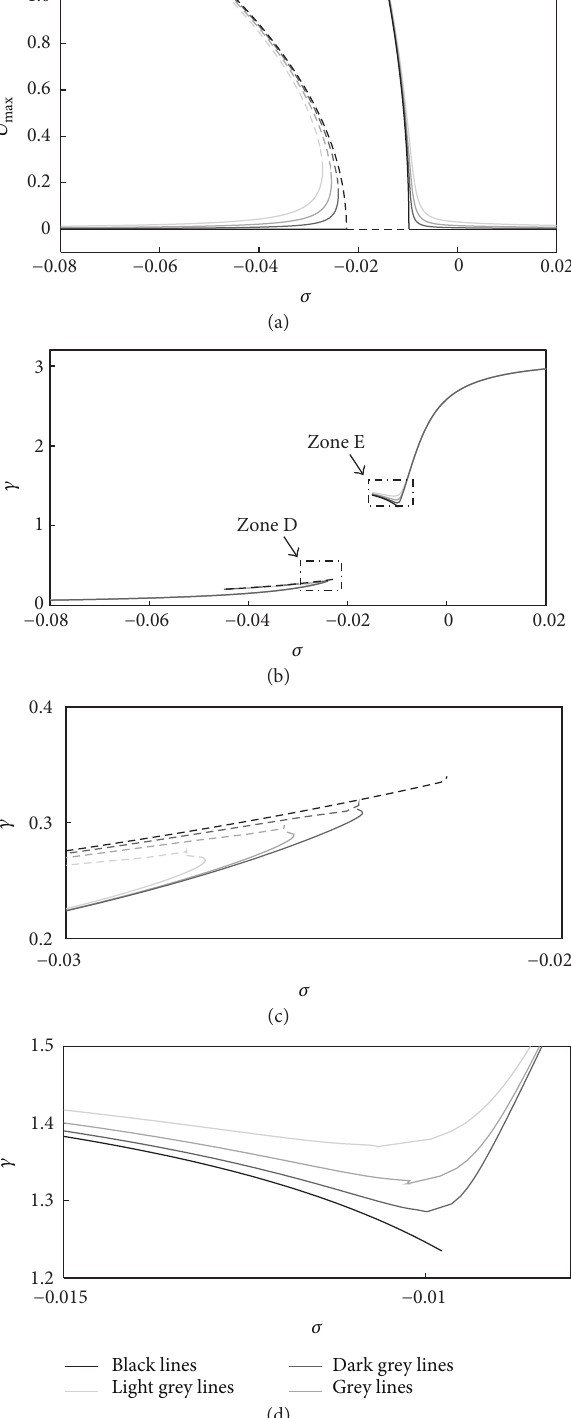
Figure 3: Continuous transition of the frequency response from Hopf bifurcation to cyclic fold bifurcation due to DC bias 𝛿 0𝐷 . AC frequency is near natural frequency. (a) Amplitude-frequency response, (b) phase-frequency response, (c) Zone D detail, and (d) Zone E detail. MMS is used. Four cases are shown in all figures: (i) zero DC bias (black lines): 𝛿 0𝐷 = 0.0, (ii) dark grey lines: 𝛿 0𝐷 = 0.00002, (iii) grey lines: 𝛿 0𝐷 = 0.00005, and (iv) light grey lines: 𝛿 0𝐷 = 0.0001. TheACvoltage, fringe, and damping are 𝛿 0𝐴 =0.1, 𝑓 =0.26, and 𝑐 = 0.01,